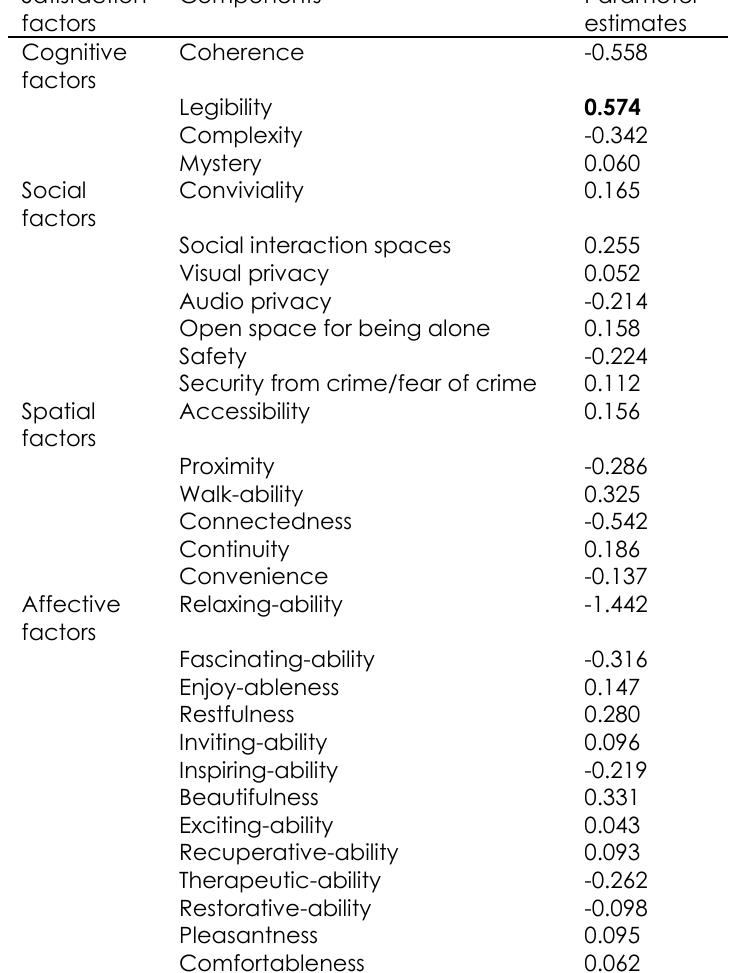
Table 9. Parameter estimates of the factors influencing users’ satisfaction with the Federal Universities campus open spaces in the study